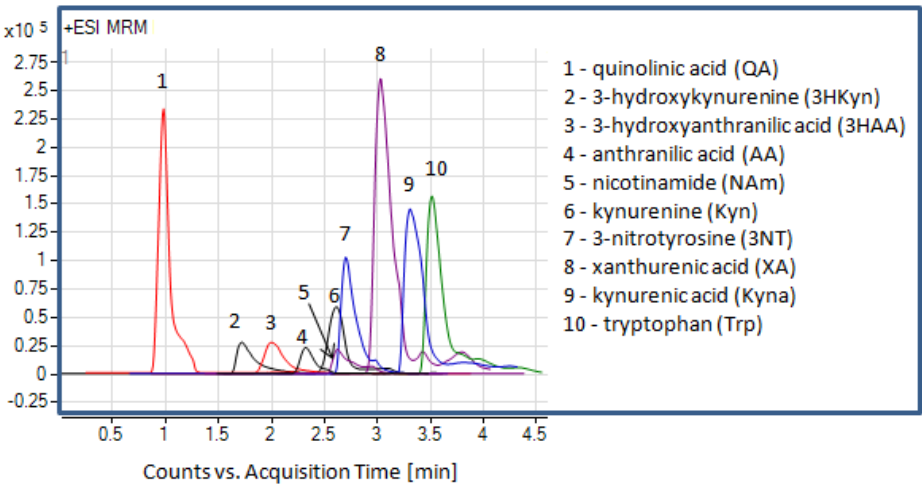
Figure 2. Overlaid monitored transitions selected for quantification of the target analytes (standards prepared in neat